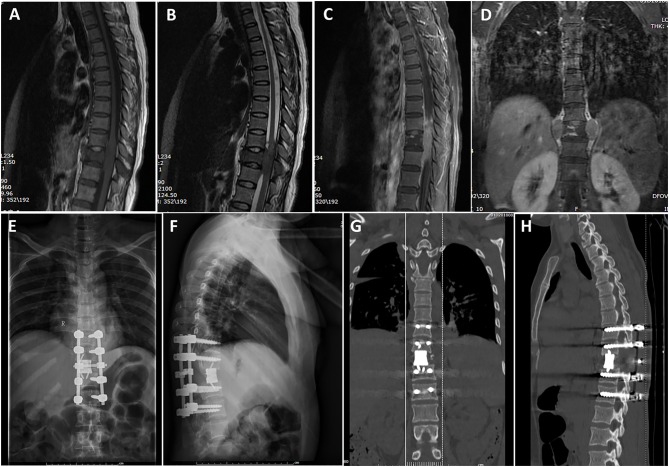
A case labeled as spinal canal type because the maximal diameter of the tumor was located in the spinal canal. Preoperative T1-weighted (A) and T2-weighted (B) images revealed a tumor at the T10–12 level. Contrast-enhanced sagittal (C) and coronary (D) images revealed that the tumor showed heterogeneous enhancement. Postoperative X-ray showed sound reconstruction by a 3D printed microporous titanium vertebral body and posterior screw-rod system. Anterior-posterior view (E). Lateral view (F). Postoperative computed tomographic scan of the thoracic spine 1 year after surgery showing excellent spinal fusion and the absence of tumor recurrence. Coronal section image (G). Sagittal section image (H).